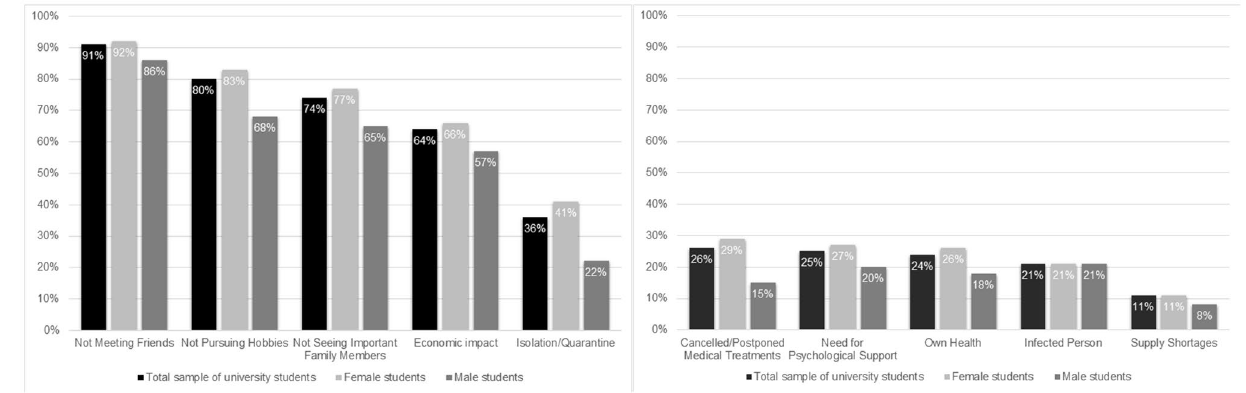
Figure 2. (a) Social stress due to the COVID-19 pandemic reported by university students in June 2020 (N = 443). ( b ) Health issues due to the COVID-19 pandemic reported by university students in June 2020 (N = 443). Note . Participants answered five questions on pandemic-related items. Answers between 1 and 4 were assigned to “no agreement” = 0, and answers between 5 and 7 “agreement” = 1 on the 7-point Likert-Scale; answer options 1 and 2 indicated “no or little” = 0 and answers from 3 to 5 “at least moderate” perceived stress/ wish for psychological support = 1 on the 5-point Likert-Scale, respectively. Scoring was in accordance with the answer options of the